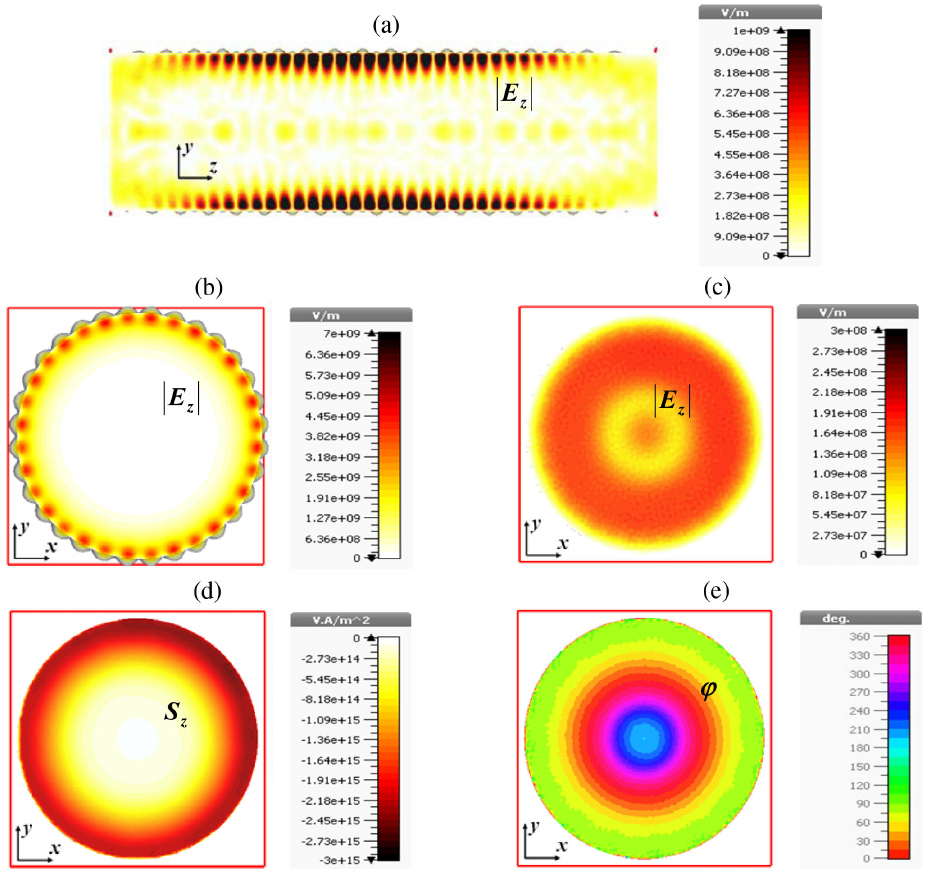
FIG. 12. CST PIC simulations of the sub-GW Ka-band 2D SWO (SINUS-6 accelerator): E correspond to interference of the axially propagating partial wave beams sections of the waveguide, as well as axial component of Poynting vector S